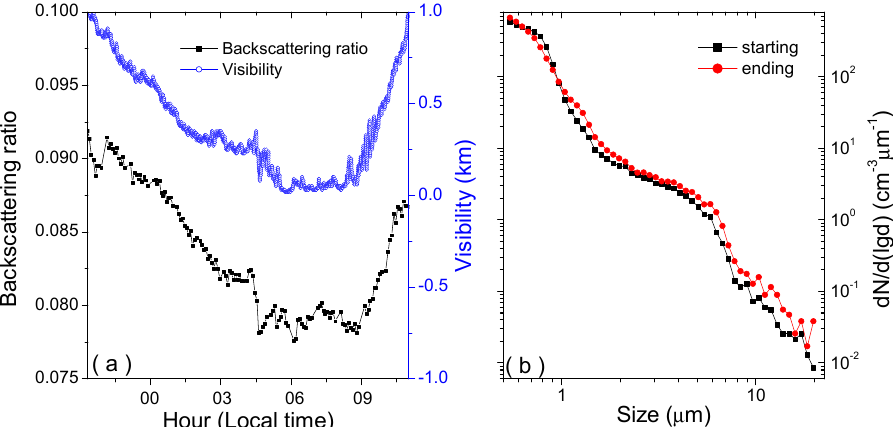
Figure 4. Variations of visibility and aerosol backscattering ratio during fog periods ( a ) and particle size distributions at the starting and ending points of fog ( b ).